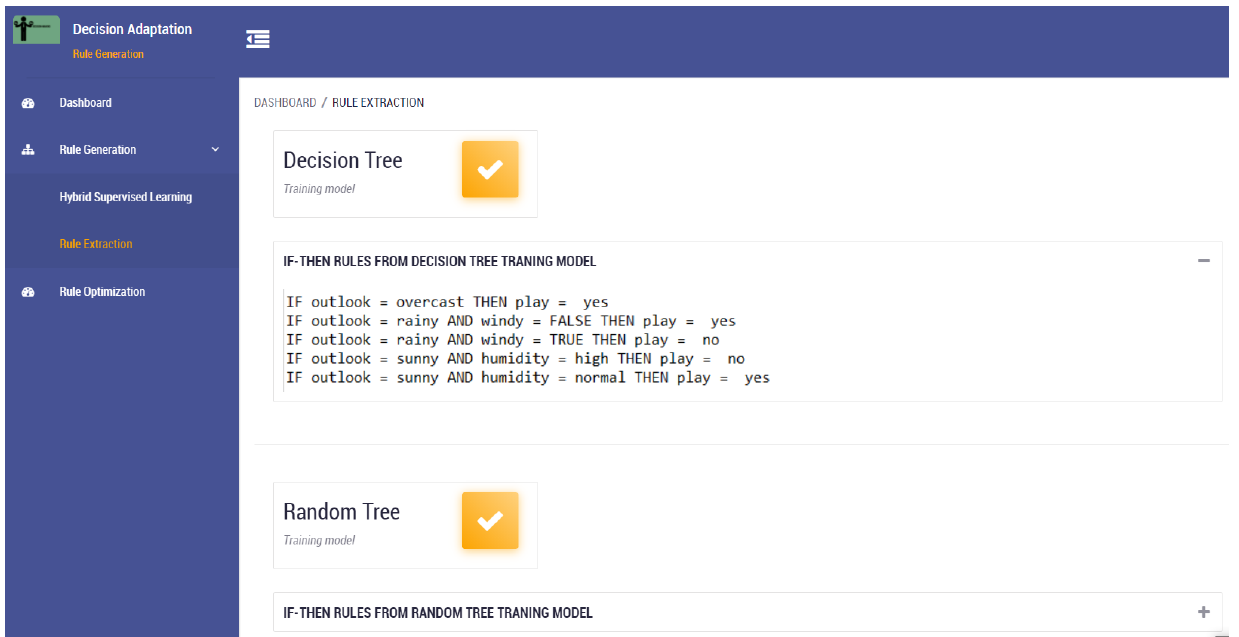
Figure 7. Validated IF-THEN rules from the Decision Tree-based training